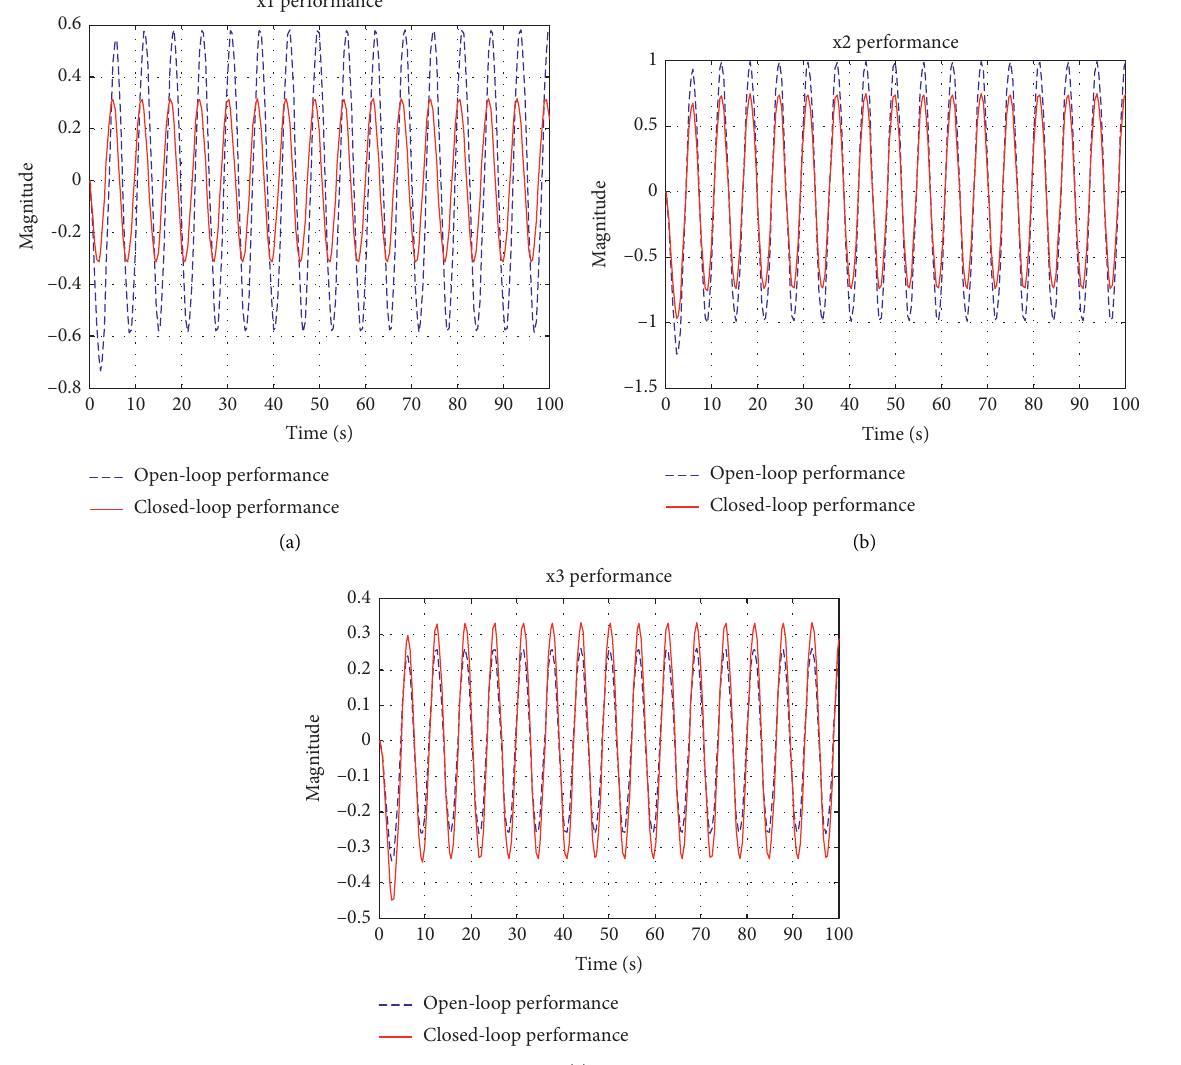
Figure 2: Restricted active vibration distribution through single node and single element control: (a) node 1 performance; (b) node 2 performance; (c) node 3